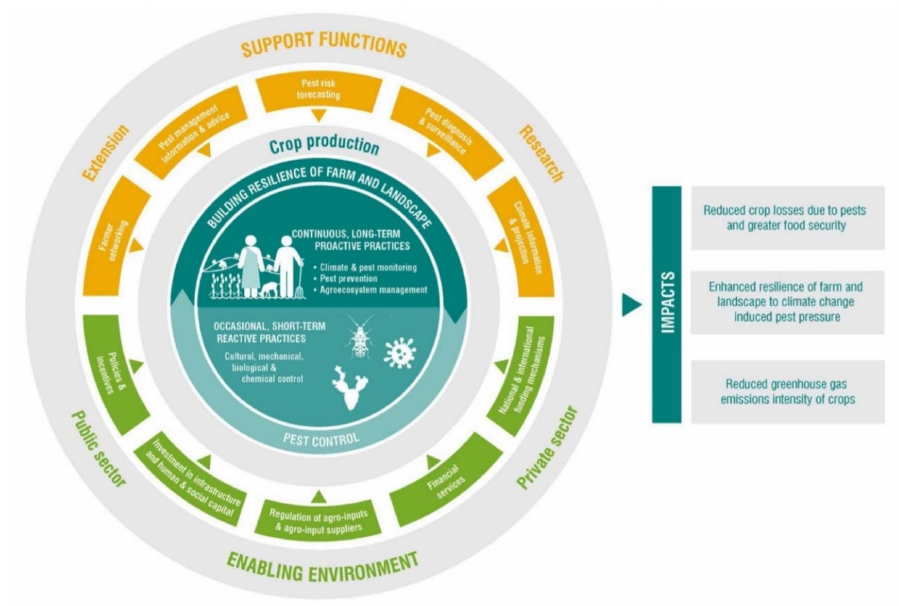
Figure 10. Schematic representation of interdisciplinary approaches and strategies for Climate-Smart Pest Management (CSPM) and its impact. (Reproduced from [157]—licensed under the Creative Commons